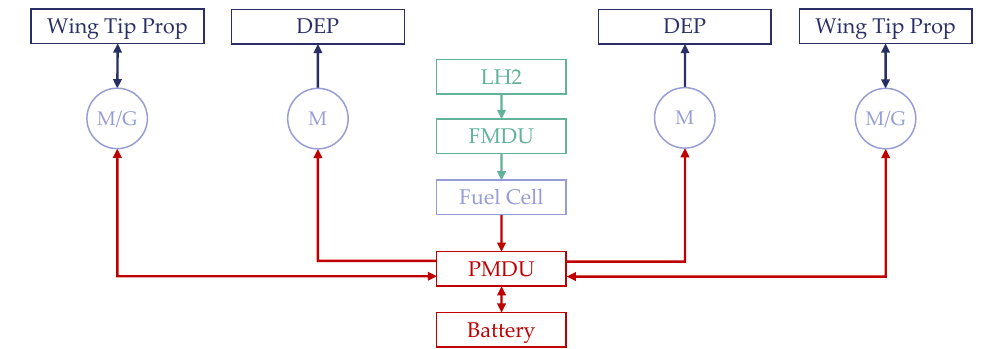
Figure A6. Architecture 6: Serial hybrid-electric architecture primarily powered by a fuel cell propelled by